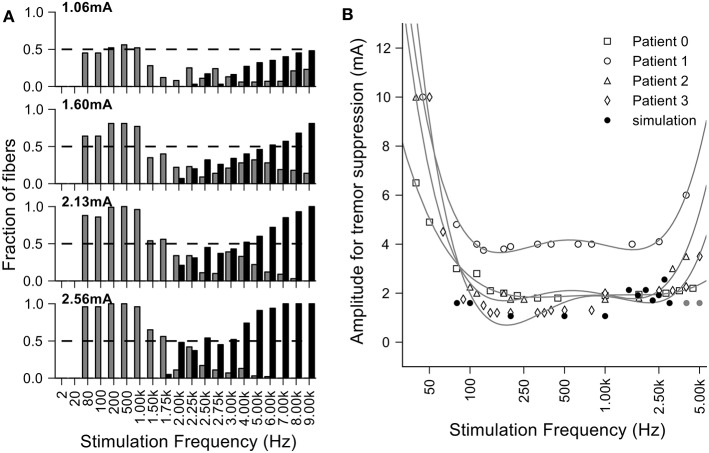
Loss of efficacy of DBS at very high frequencies can be explained by increases in entropy. (A) Fraction of fibers where the entropy of the output firing is <1 bit per spike at different amplitudes and frequencies of stimulation. The fibers that have a regular output pattern are depicted in gray and those that undergo conduction block in black. For large stimulation currents and higher frequencies, we did not see regularized firing due to the occurrence of conduction block and the finite extent of the population of model nerve fibers. (B) Overlay of the clinical data from Benabid et al. (1991) (each point was normalized by the per patient minimum value and then multiplied by the average of the minimum values across patients) and the minimal amplitude to regularize half of the fibers in the simulations.